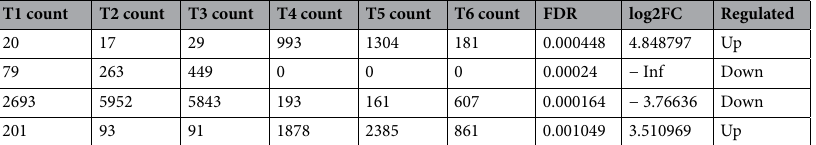
Table 2. Differentially expressed gene results of Sc. 1 (before infection) and Sc. 2 (after infection). Count the Count value of gene expression of the samples, FDR error detection rate, Log2FC logarithm value of expression amount difference multiples, Regulated up- or down-regulated